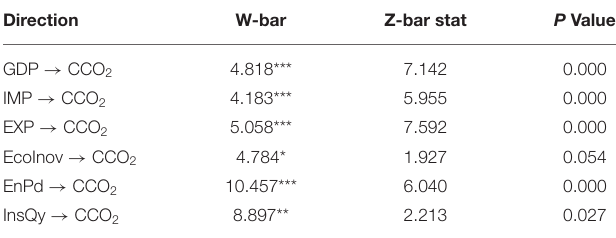
TABLE 8 | Causality analysis. Direction W-bar Z-bar stat P